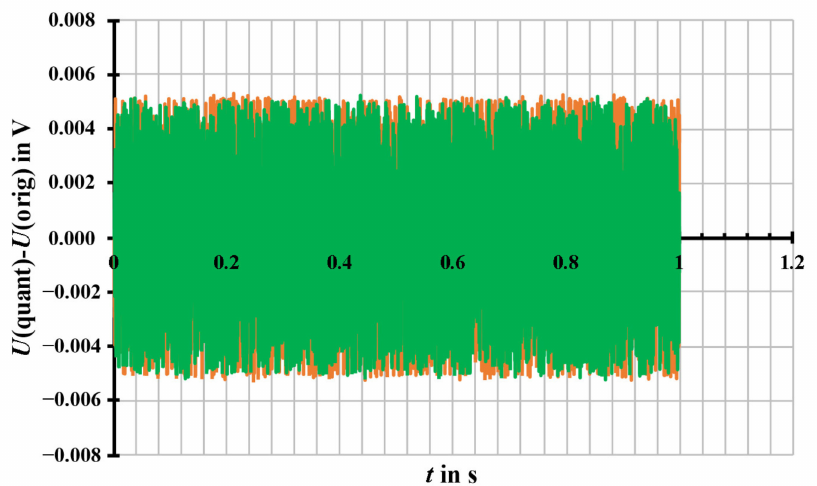
Figure 12. The di ff erence between the generated signals, set by the PC and the quantized signals, sent by SV generator box (green: U 1 = 1 V, orange: U 1 = 100 V) in time domain. The signals are simulated with parameters of f S = 4000 Hz, T W = 1 s, f 1 = 50.1 Hz, and ϕ 1 = 0 ◦ with di ff erent RMS values of the amplitude U 1 = 1 V / 100 V, without noise and